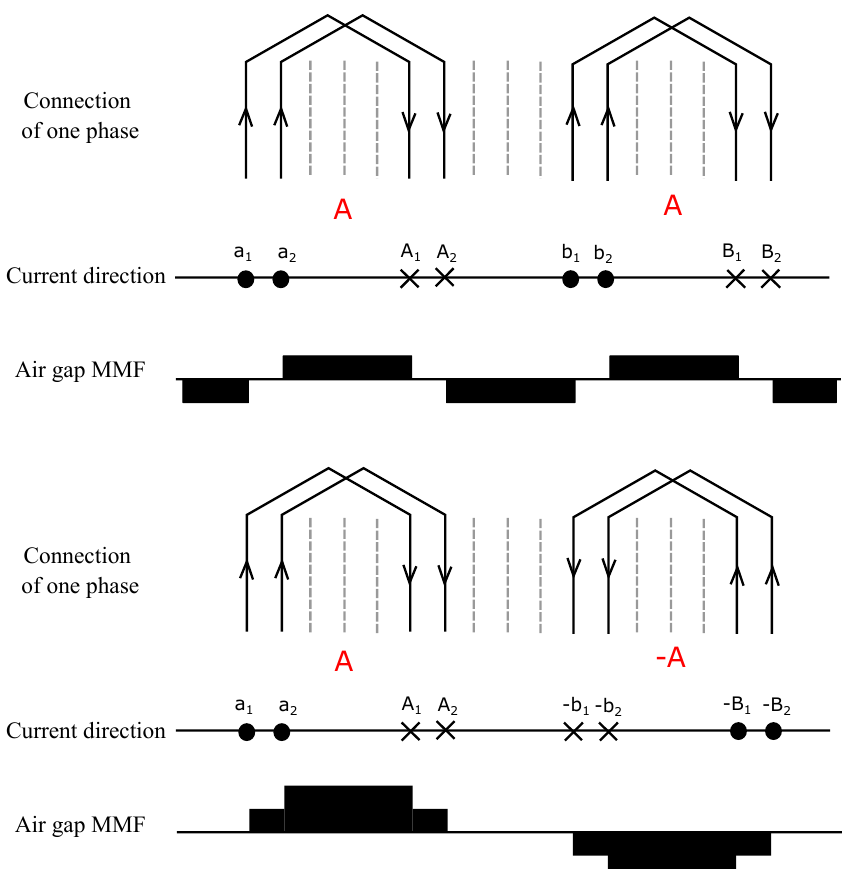
Figure 3. Sketch of four-pole and two-pole